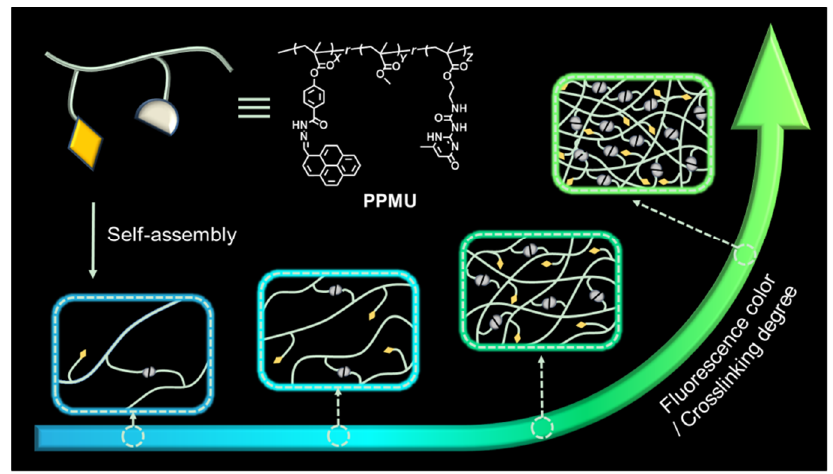
Scheme 1. Chemical structure of polymer chain PPMU , and cartoon representations of its proposed crosslinking process into supramolecular polymer networks and the change of fluorescence color with increasing concentrations of PPMU solutions.